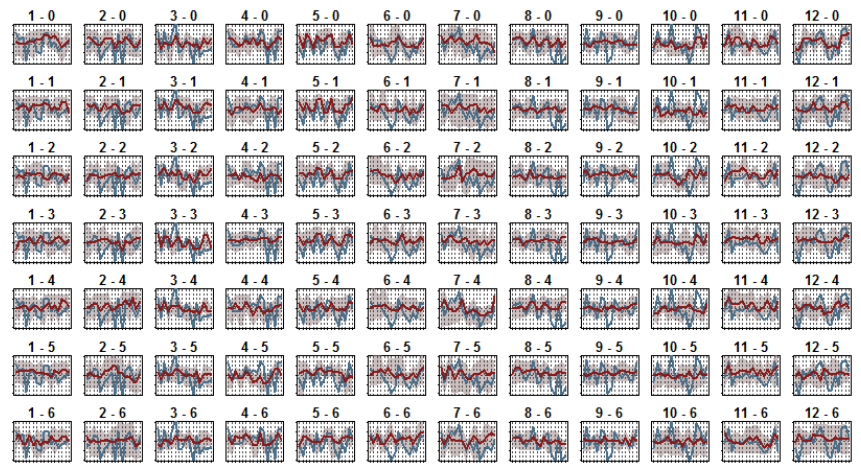
Figure 3. Results of the random-forest-based monthly precipitation forecast models (red) and observations (blue) for the northern central Asia for the period from 1996 to 2010 ( x axis). Values are displayed as monthly SPI values between − 2 and 2. The numbers indicate the month for which the forecast is conducted and the particular lead time (e.g., the panel indicating 1–2 shows the results for January precipitation based on predictor variables from November). The shaded area indicates the range of prediction values of all single-tree models belonging to the random forest forecast model.